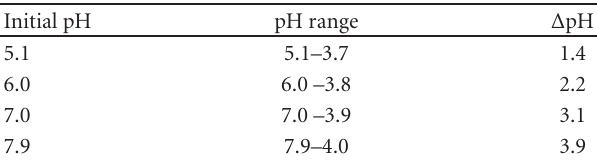
Table 1: Change in pH at various values of initial pH with Na 2 HPO 4 .